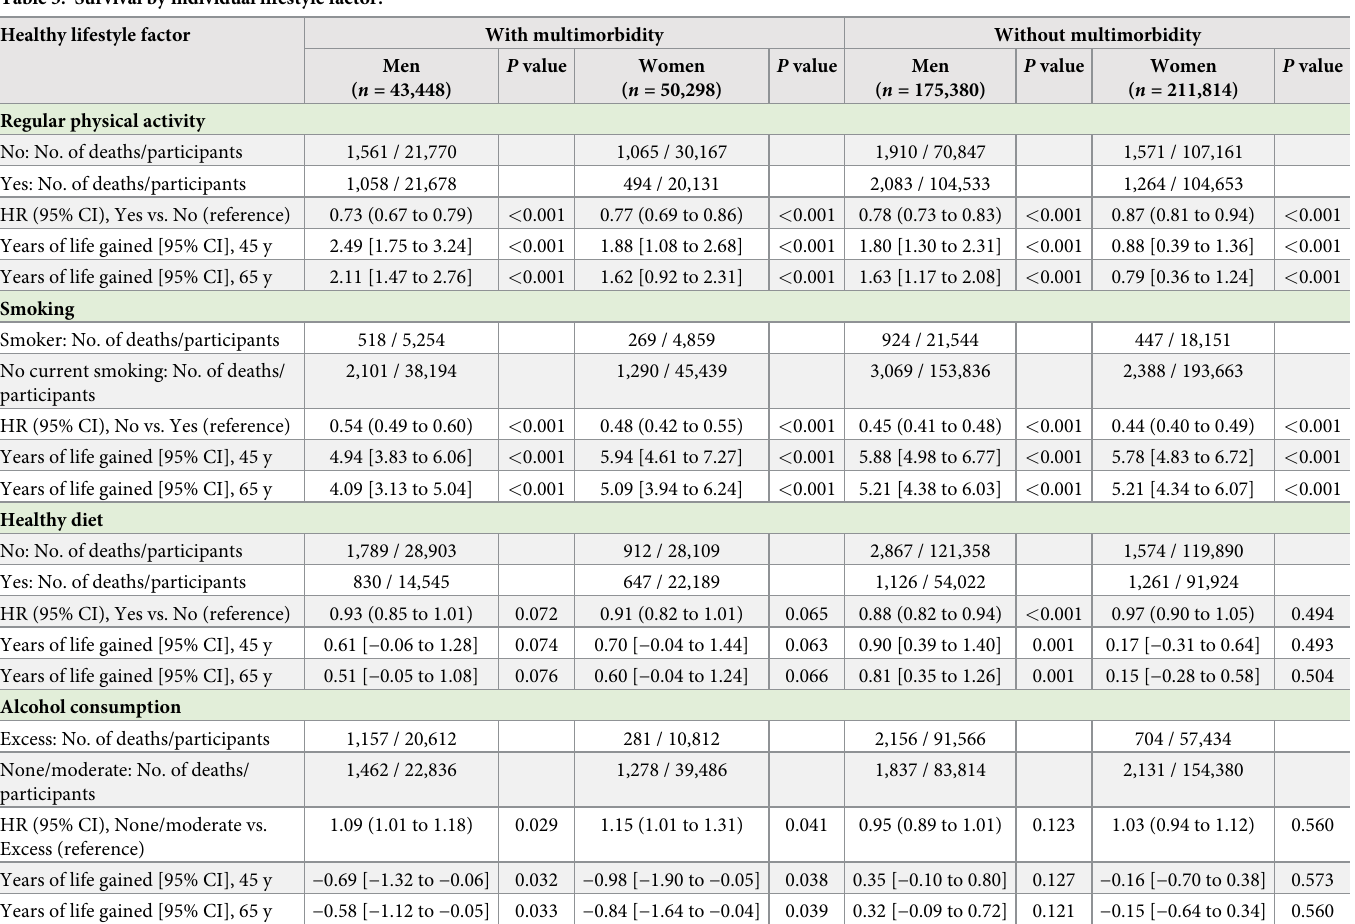
Table 3. Survival by individual lifestyle factor.